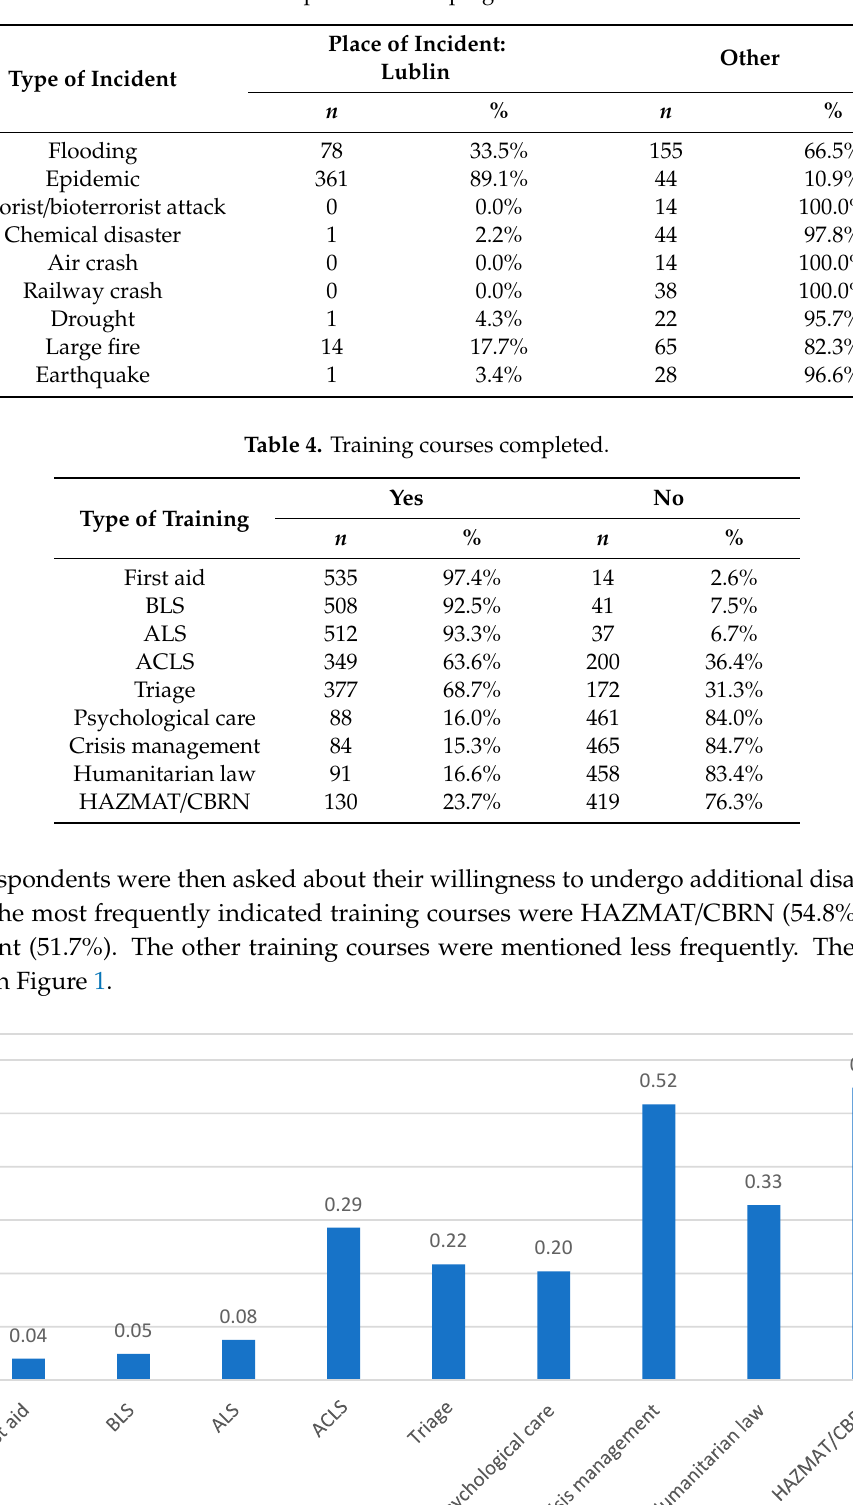
Table 3. Experience in helping disaster victims.